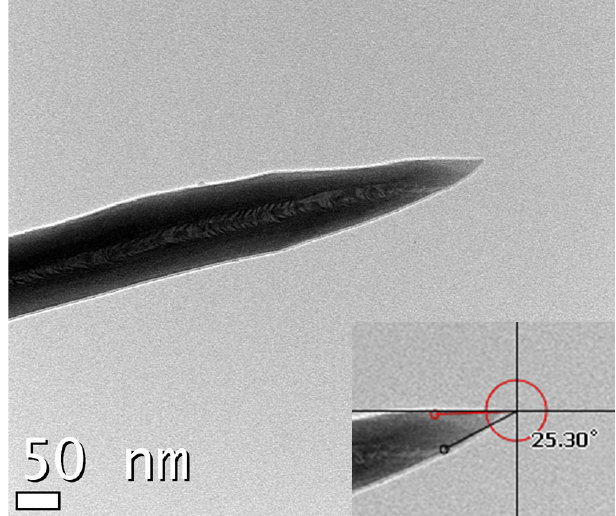
Figure 4. TEM image of a magnified image of the tip apex of a CNT